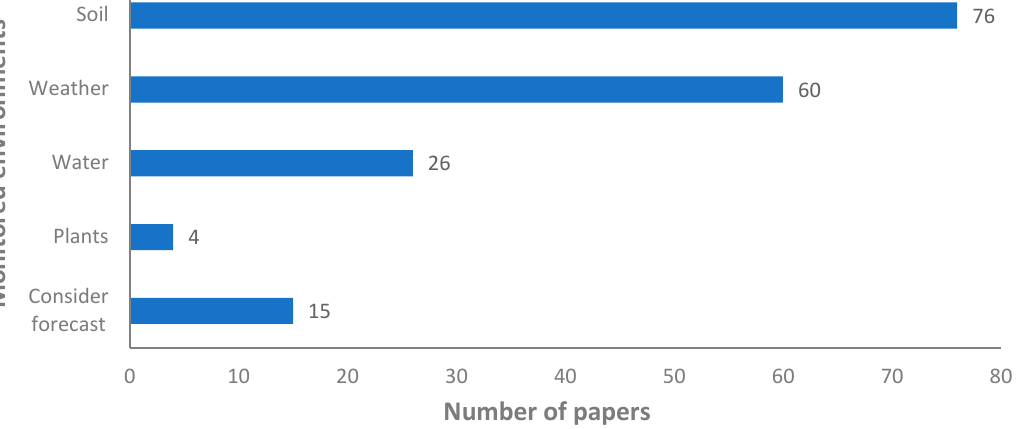
Figure 6. Number of monitored parameters in papers that propose an irrigation system. Next, the details about the measured parameters are shown. Regarding the sensors of soil, plants, and water (see Figure 7), the most used sensor in the systems is the soil moisture sensor, it is used in 76 papers (more details in Section 4). First, we will analyze the data from soil and plant